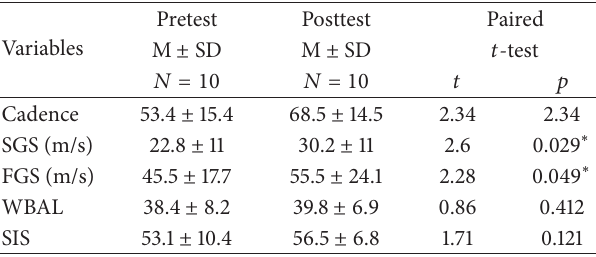
Table 4: Within-group comparison of the dependent variable in LORT